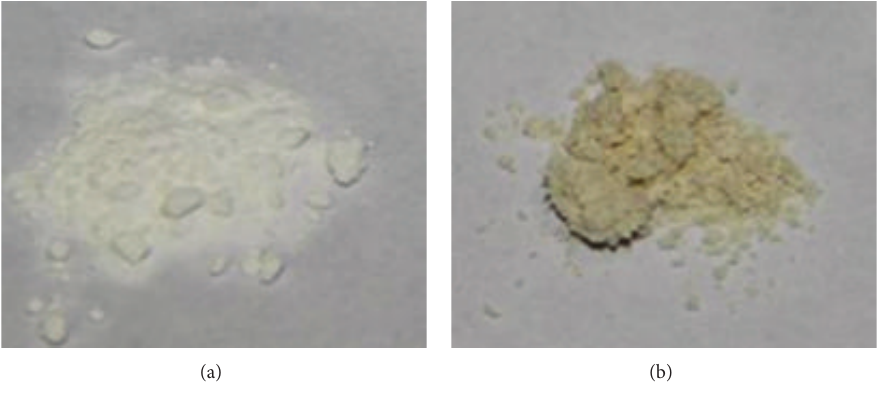
Figure 3: Picture of Klys/leu powders after nanospray process using 7 (#1, a) and 4 𝜇 m nozzle (#5, b).